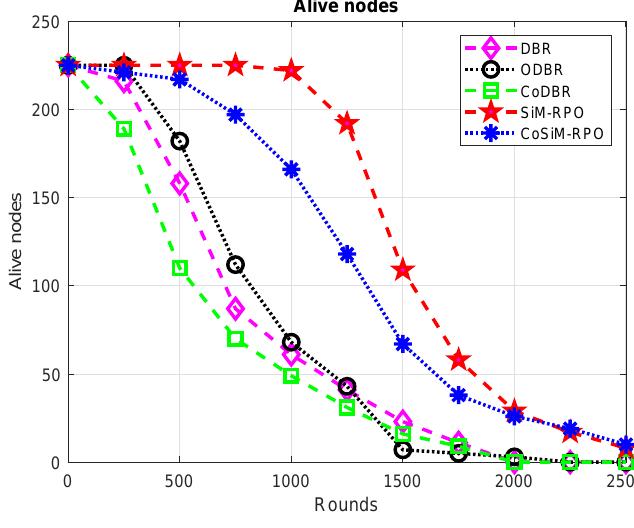
Figure 10. Number of alive